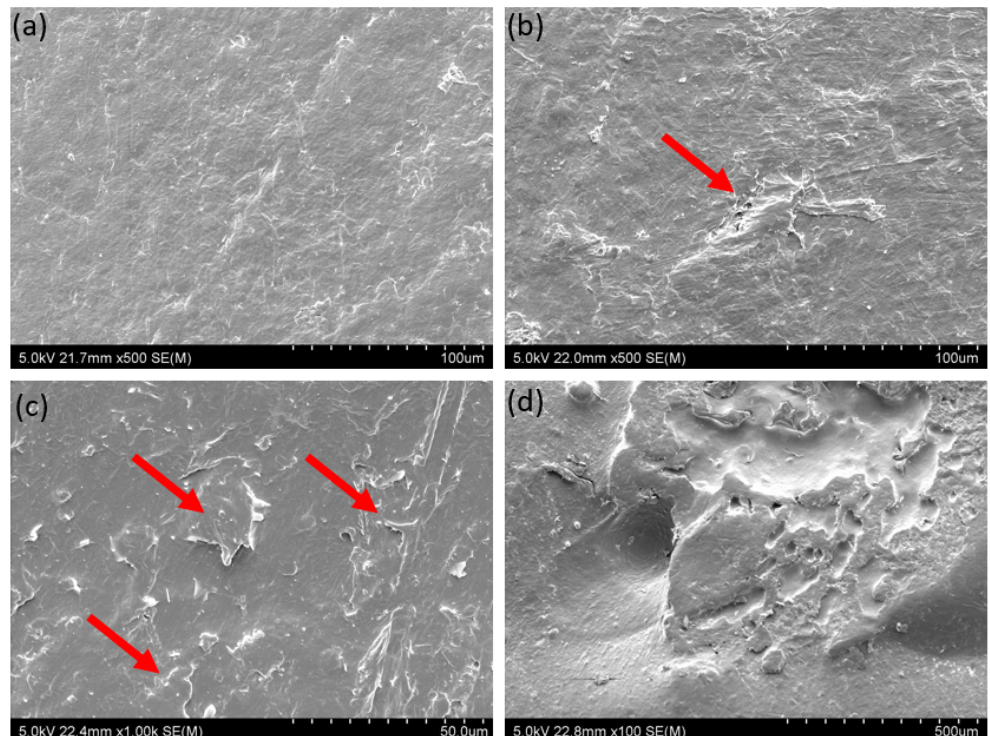
Figure 7. SEM micrographs of the surface of a PP granule in as-received condition ( a ), smeared material on the surface of a granule after 500 cycles in compression ( b ), protruding pieces of material form a granule after 1000 cycles in compression ( c ), and area after separation from an adhered granule ( d ).